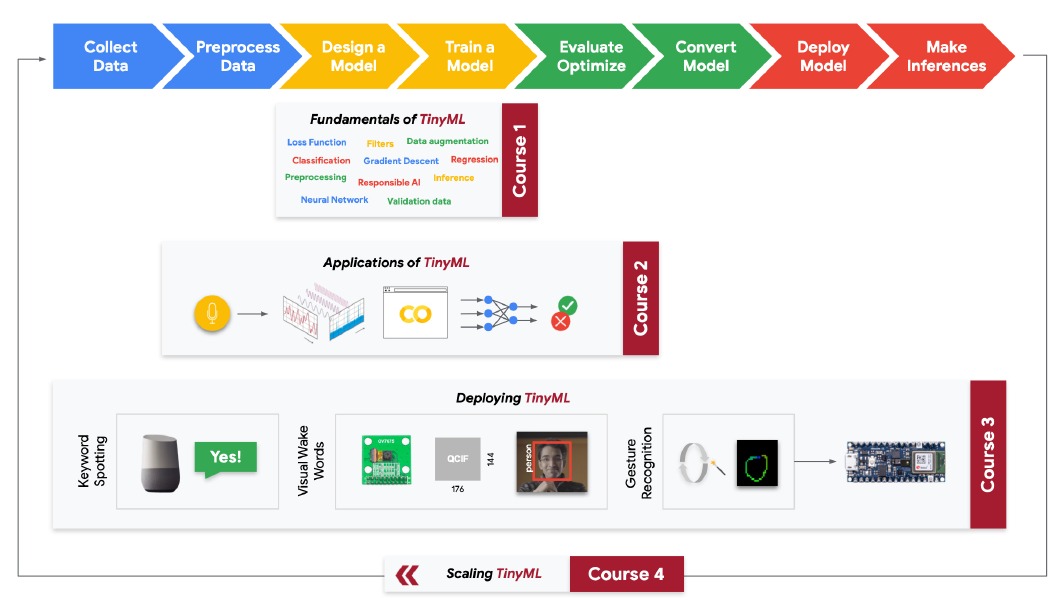
Figure 5. The ML workflow from data collection to model training to